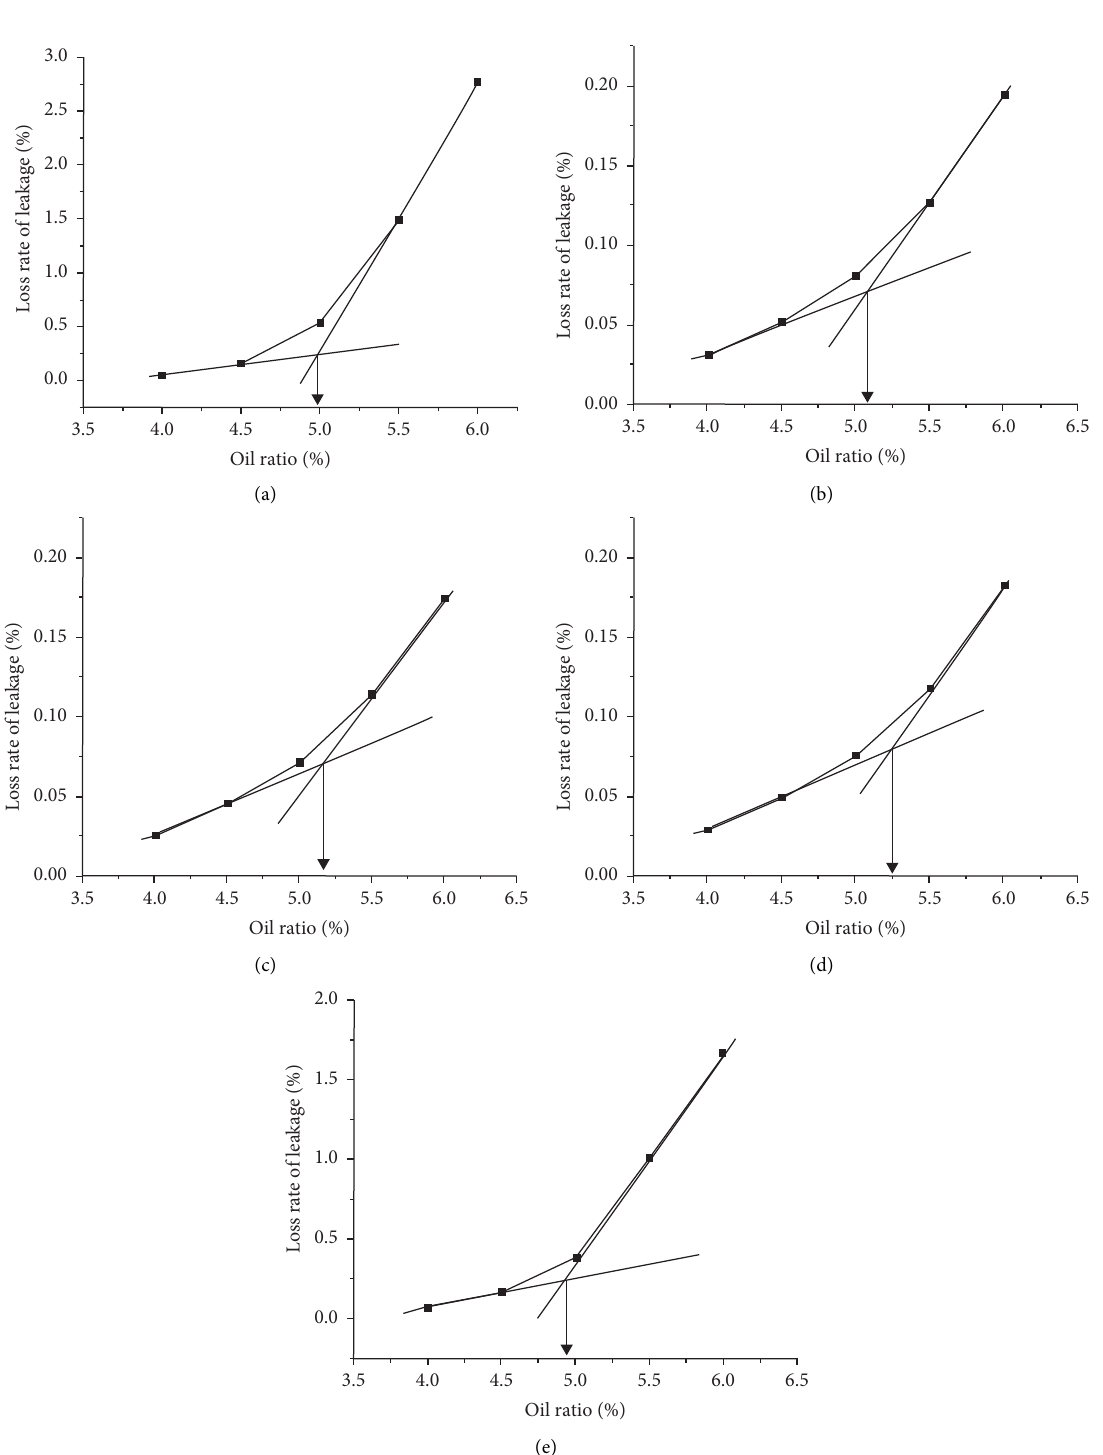
Figure 3: Leakage loss-whetstone ratio diagram. (a) Leakage loss-oil-aggregate ratio diagram of fiber-less SBS. (b) The leakage loss-oil- aggregate ratio diagram of 0.15% SBS fiber. (c) The leakage loss-oil-aggregate ratio diagram of 0.25% SBS fiber. (d) The leakage loss-oil- aggregate ratio diagram of 0.35% SBS fiber. (e) TPS leakage loss-oil-rock ratio